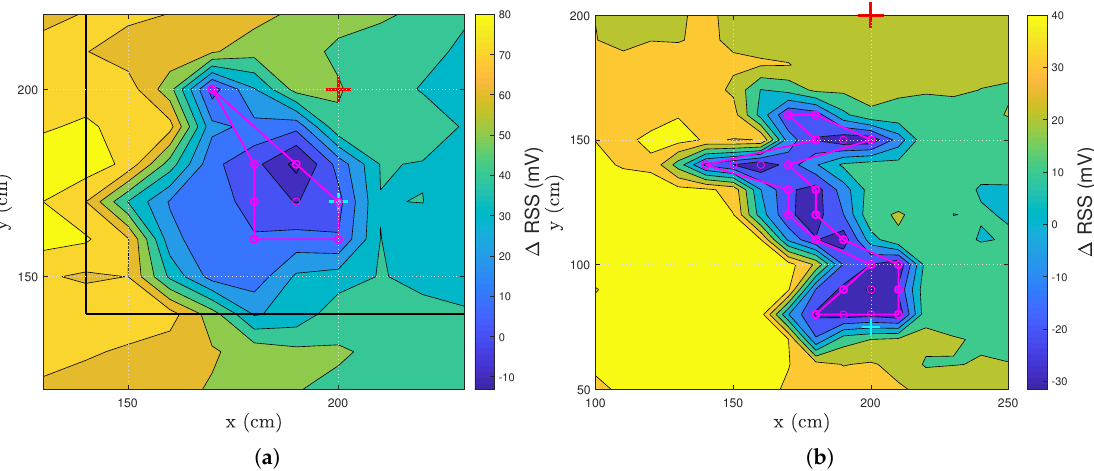
Figure 4. Detailed result of the ∆ RSS drop of later mentioned results. ( a ) Layout 1, ( b ) layout 3. The red cross represents the LED, while the cyan cross denotes the PD. The black line represents the extent of the occurrence area.